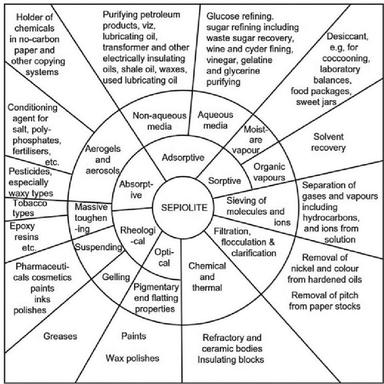
Scheme illustrating some old applications received by sepiolite as reported 65 years ago by Robertson (Reproduced with permission from Elsevier (Alvarez ´).